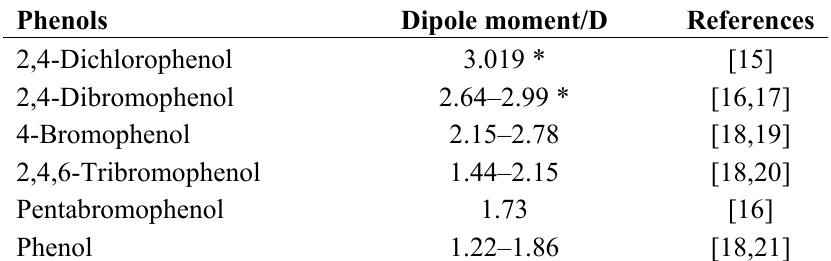
Table 2. Dipole moment